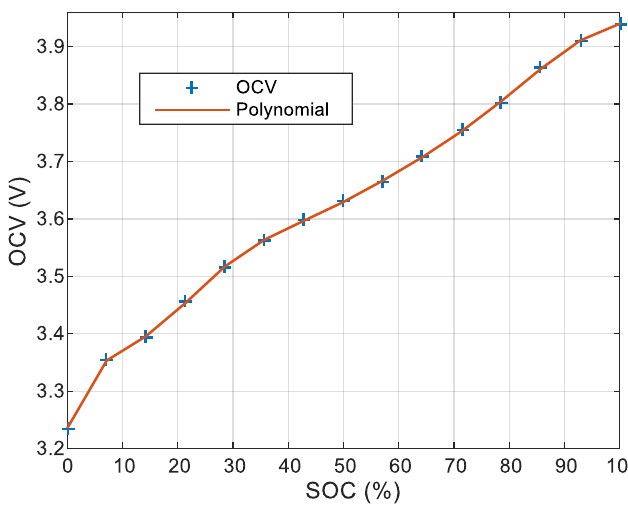
Figure 8. Considered cell open circuit voltage (OCV) fitted by a degree 10 polynomial.